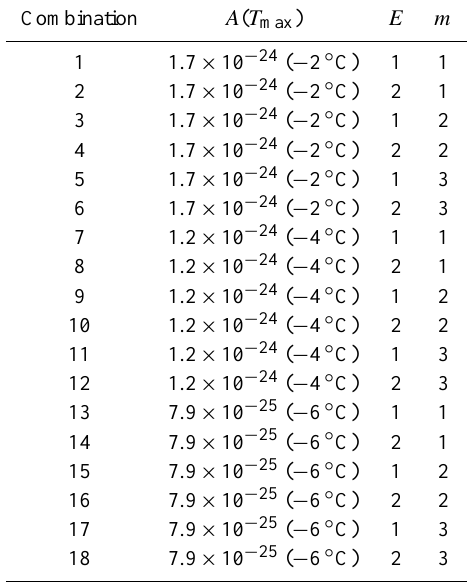
Table 1. List of values for the rate factor ( A) , enhancement factor ( E) , and basal sliding exponent ( m) used in the model simulations. The maximum width- and depth-integrated ice temperature ( T max ) used to calculate the rate factor is also